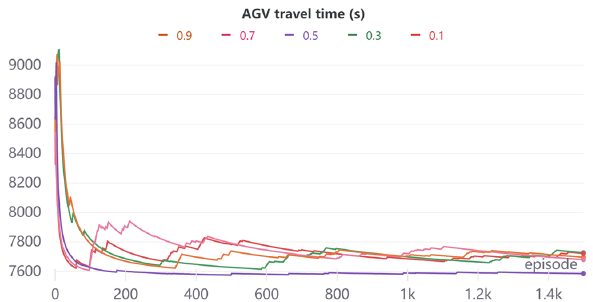
Figure 8. AGV travel time of CDA algorithm with different values of 𝛽 .